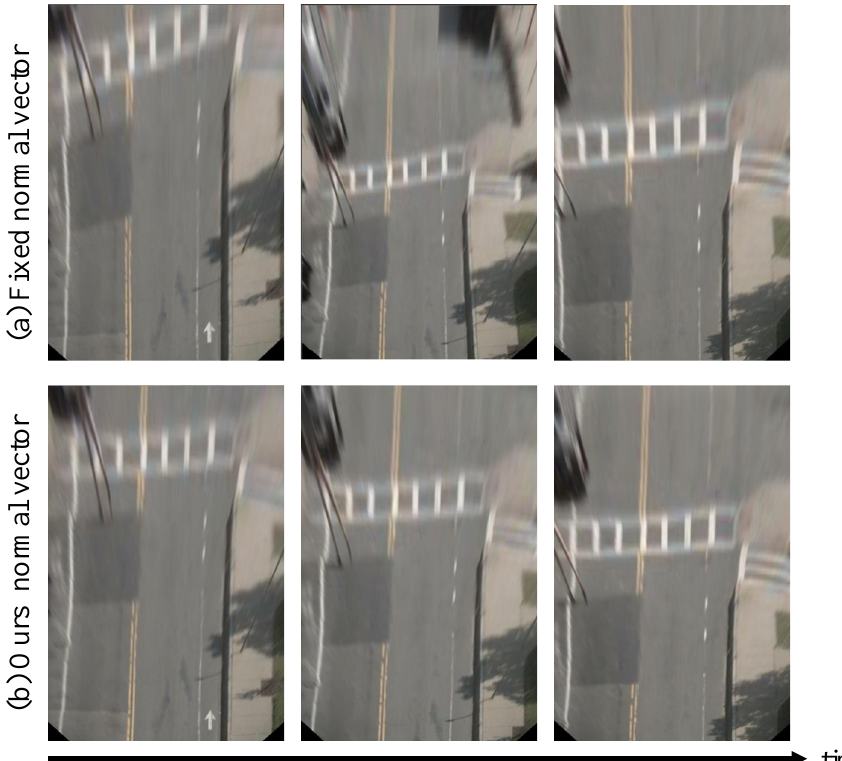
Figure 10. IPM visualization on the nuScenes dataset.